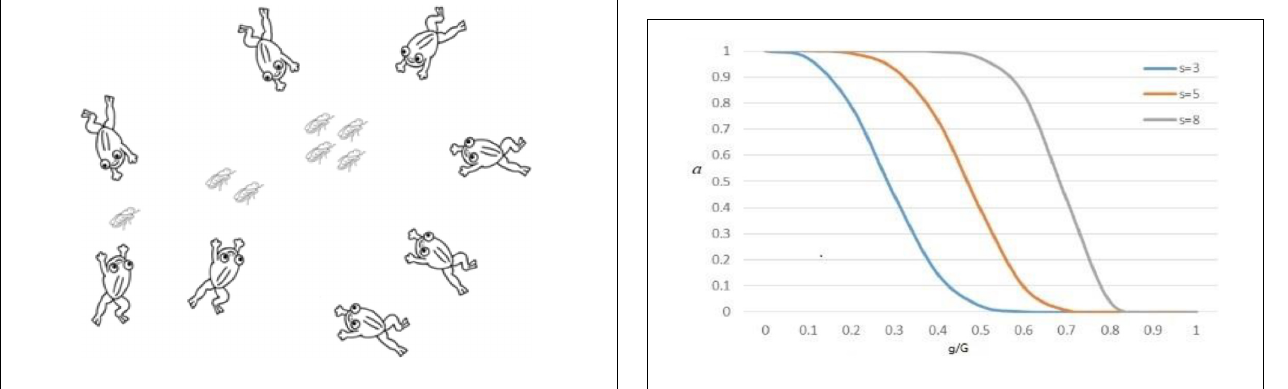
FIGURE 1 | The simulation diagram of biological characteristics of SFLA. FIGURE 2 | The curve of function